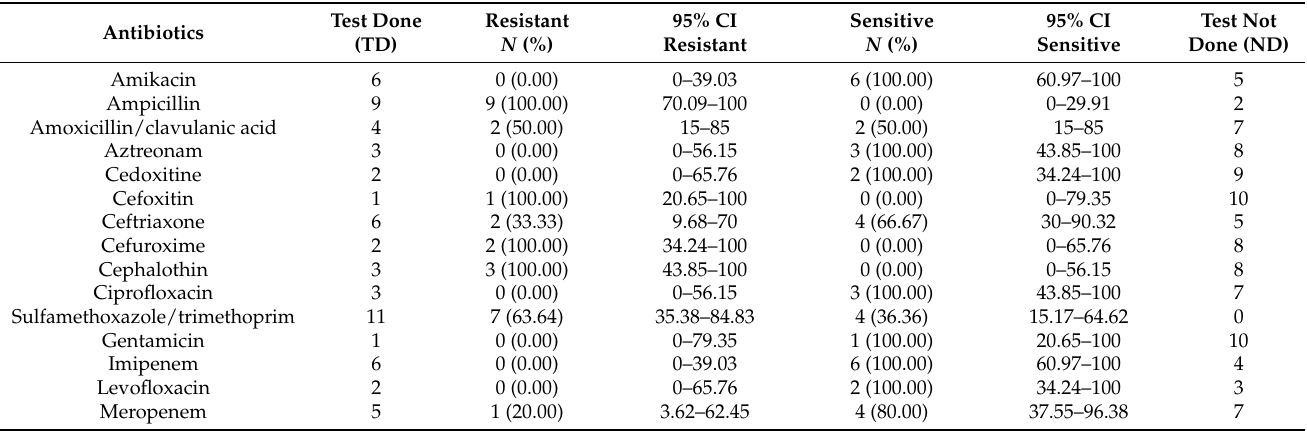
Table 4. Susceptibility pattern of K. pneumoniae in pediatric UTI patients.